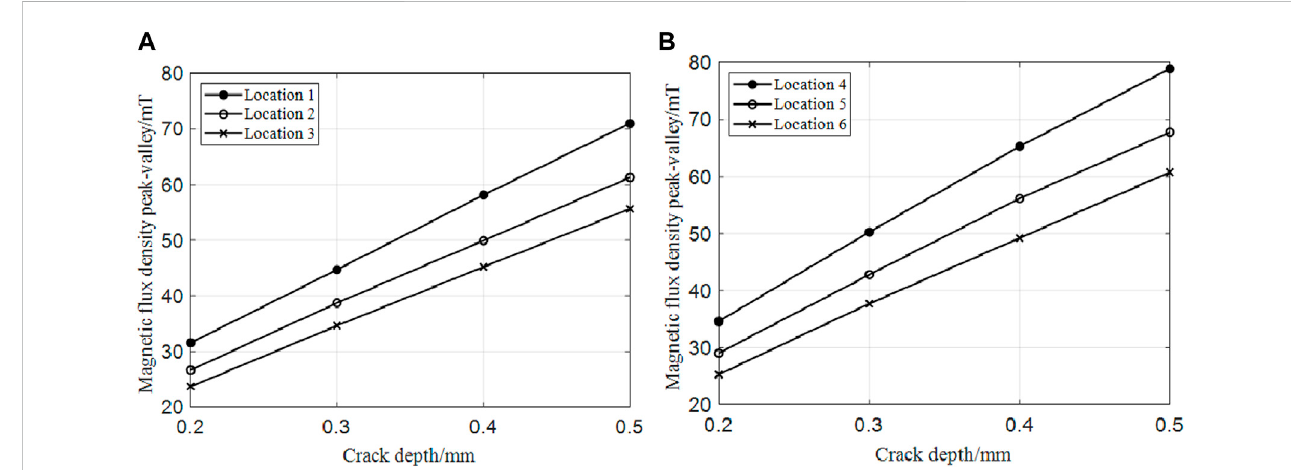
FIGURE 6 (A) Peak-valleyvaluesofMFLsignalsatdifferentaxiallocationsofthesamecrackintheouterbearingring (B) Peak-valleyvaluesofMFLsignalsatdifferent axial locations of the same crack in the inner bearing